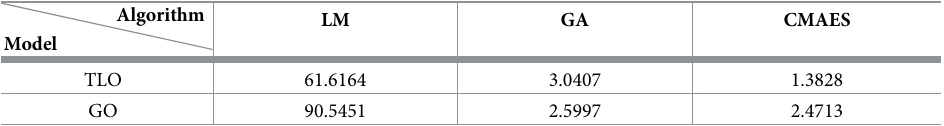
Table 2. Performance evaluation of local and global optimization algorithms.